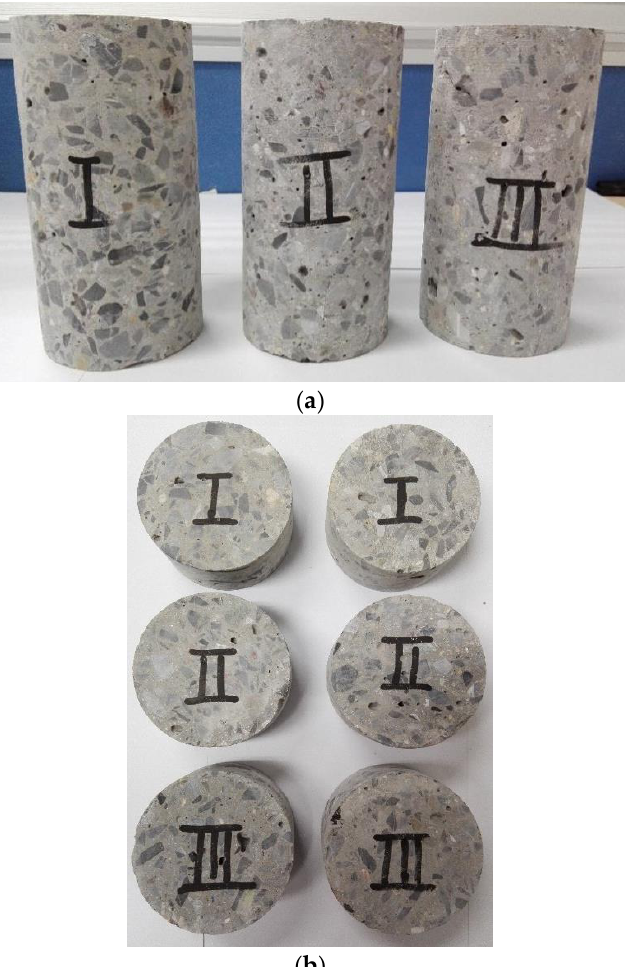
Figure 1. Images of the series I, II, III concrete BD specimens: ( a ) For quasi-static loading tests; ( b ) For impact loading tests.